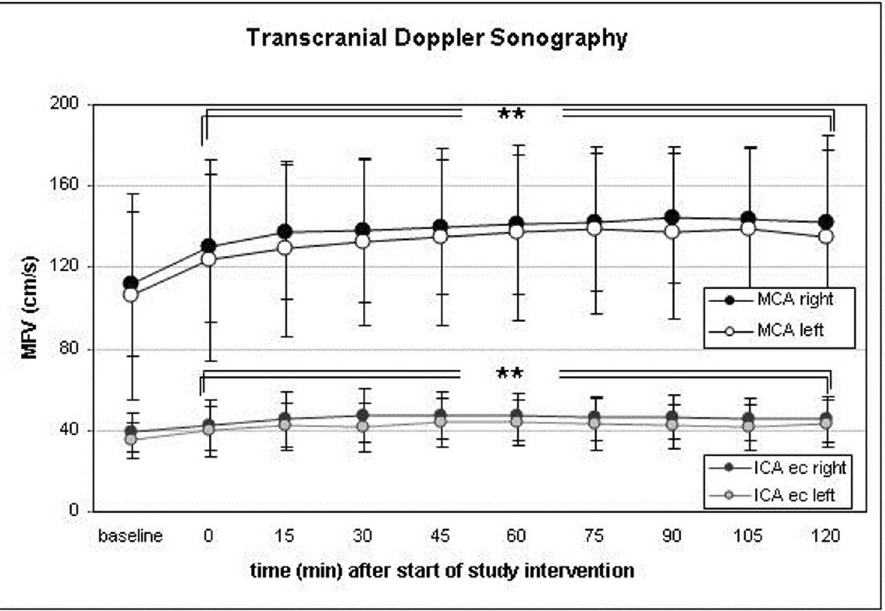
Figure 4. Mean flow velocities (MFV) in transcranial Doppler sonography (TCD) increased during the study intervention in all intracranial vessels. The graph exemplarily depicts the course of MFV in both middle cerebral arteries. The parallel increase of MFV in the high cervical extracranial internal carotid artery (ICA ec) indicates that the increase of flow velocities is due to a global increase of cerebral blood volume and perfusion. (*p < 0.05, **p < 0.01, ***p < 0.001). Data presented as Mean ± SD; 1-way ANOVA for Repeated Measurements; *p < 0.05, **p < 0.01, ***p < 0.001, plots and error bars presented as Mean ± SD (standard